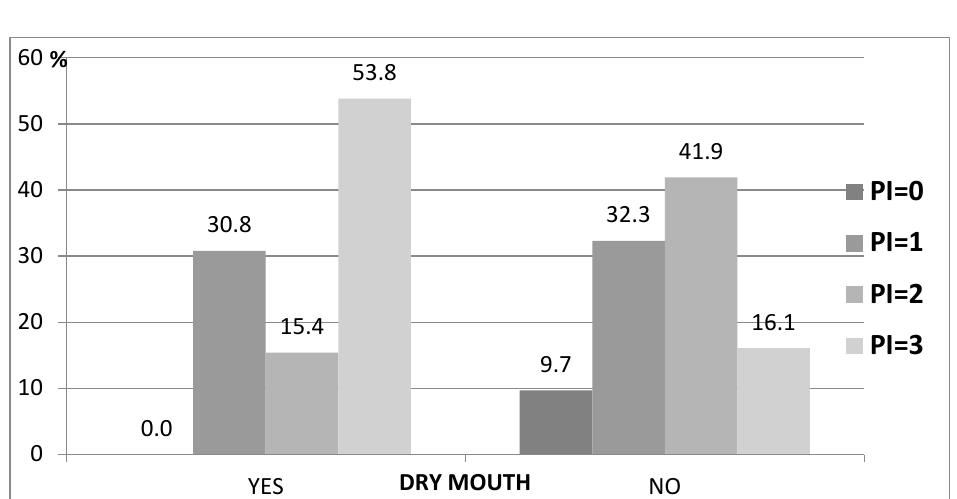
Figure 3. Relationship between PI and dry mouth.